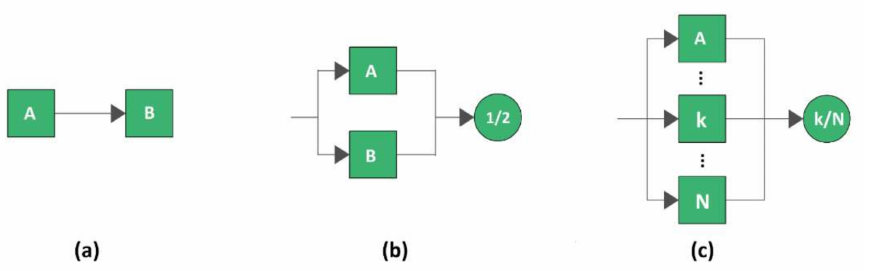
Figure 1. RBD Configuration types includin generic items A and B. ( a ) series, ( b ) parallel, ( c ) kooN